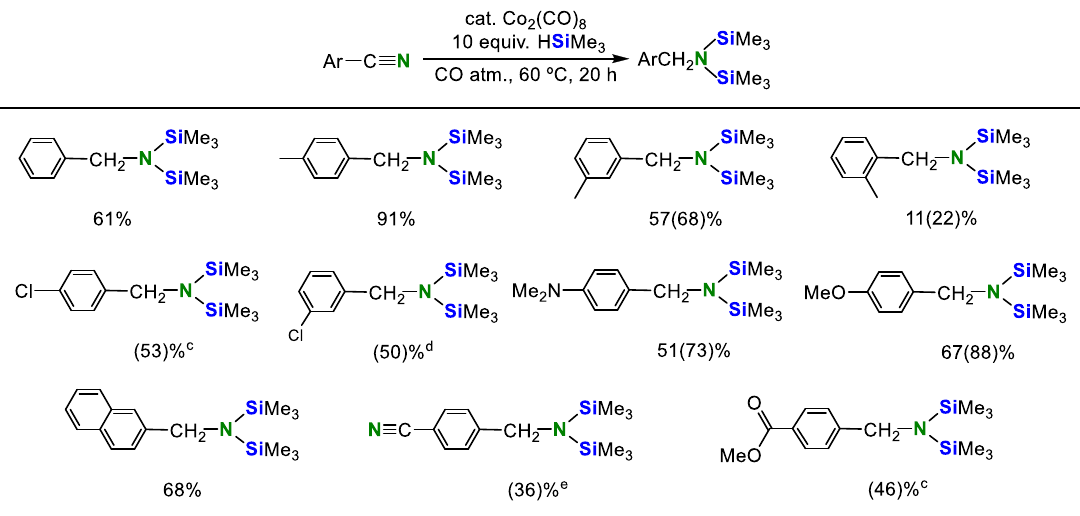
Table 1. Cobalt carbonyl catalyzed double hydrosilylation of aromatic nitriles a,b .